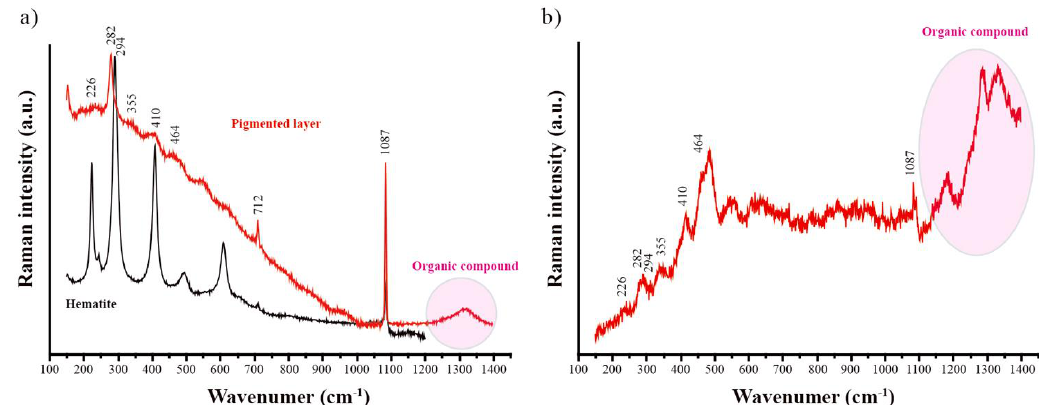
Figure 8. Raman spectroscopy of the bulk fraction of the pigmented layer of the cistern plaster. ( a ) Raman spectra showing the highest intensities bands of calcite, hematite, and quartz. ( b ) Raman spectra showing an organic compound in the region of 1150 – 1450 cm −1 . Calcite bands at 282 cm −1 , 712 cm −1 , and 1087 cm −1 ; hematite bands at 226 cm −1 , 294 cm −1 , and 410 cm −1 ; quartz bands at 355 cm −1 and 464 cm −1 .